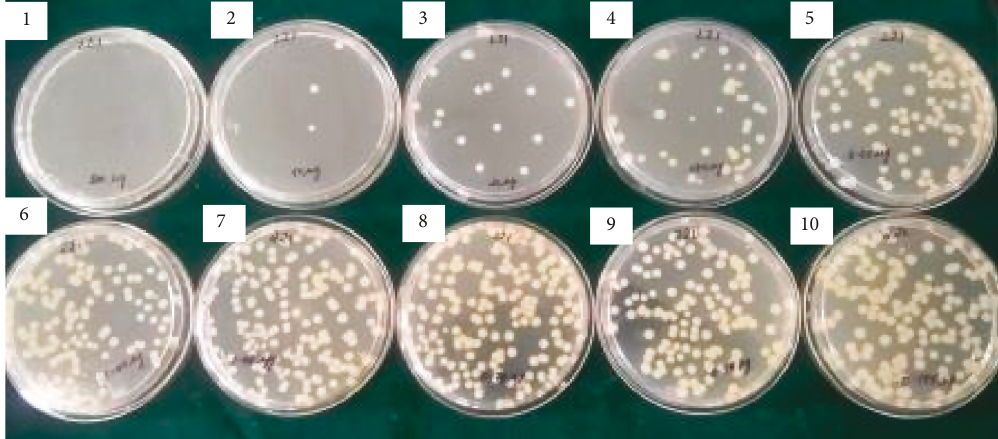
Figure 1: A representative image showing an MPC of 100 μ g against MDR Klebsiella pneumoniae . Complete growth inhibition at 100 μ g concentration of